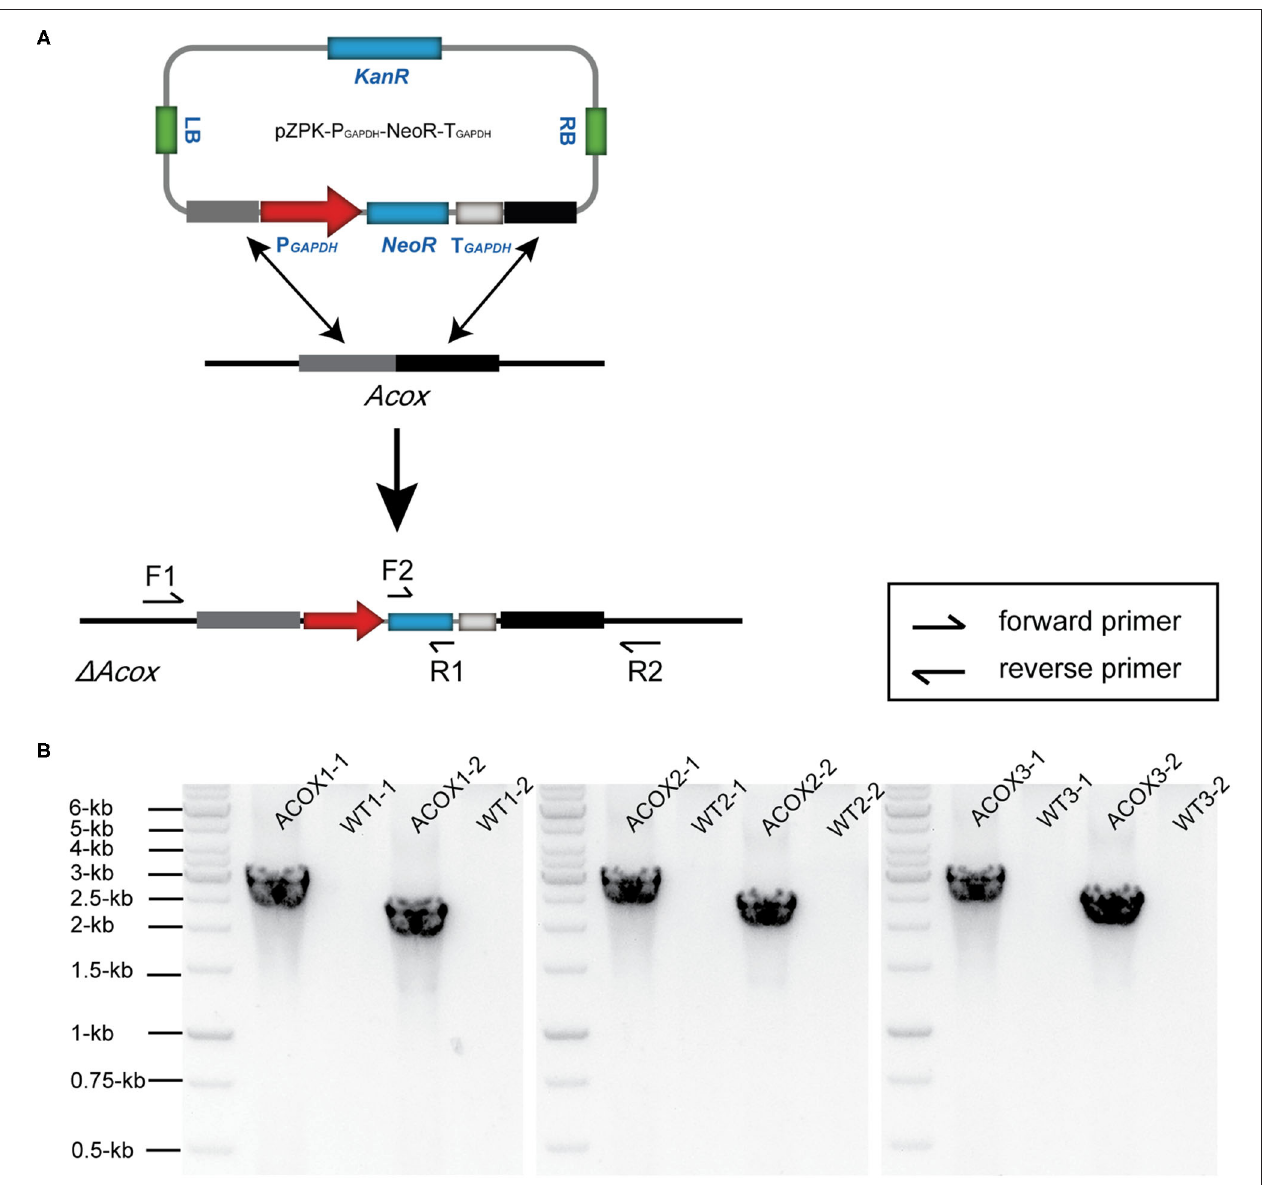
FIGURE 4 | Disruption of the genes Acox1-3 in HX-308. (A) The schematic diagram of the disruption of the genes Acox1-3 . (B) Diagnostic PCR confirmation of the mutants ACOX1, ACOX2, and ACOX3.